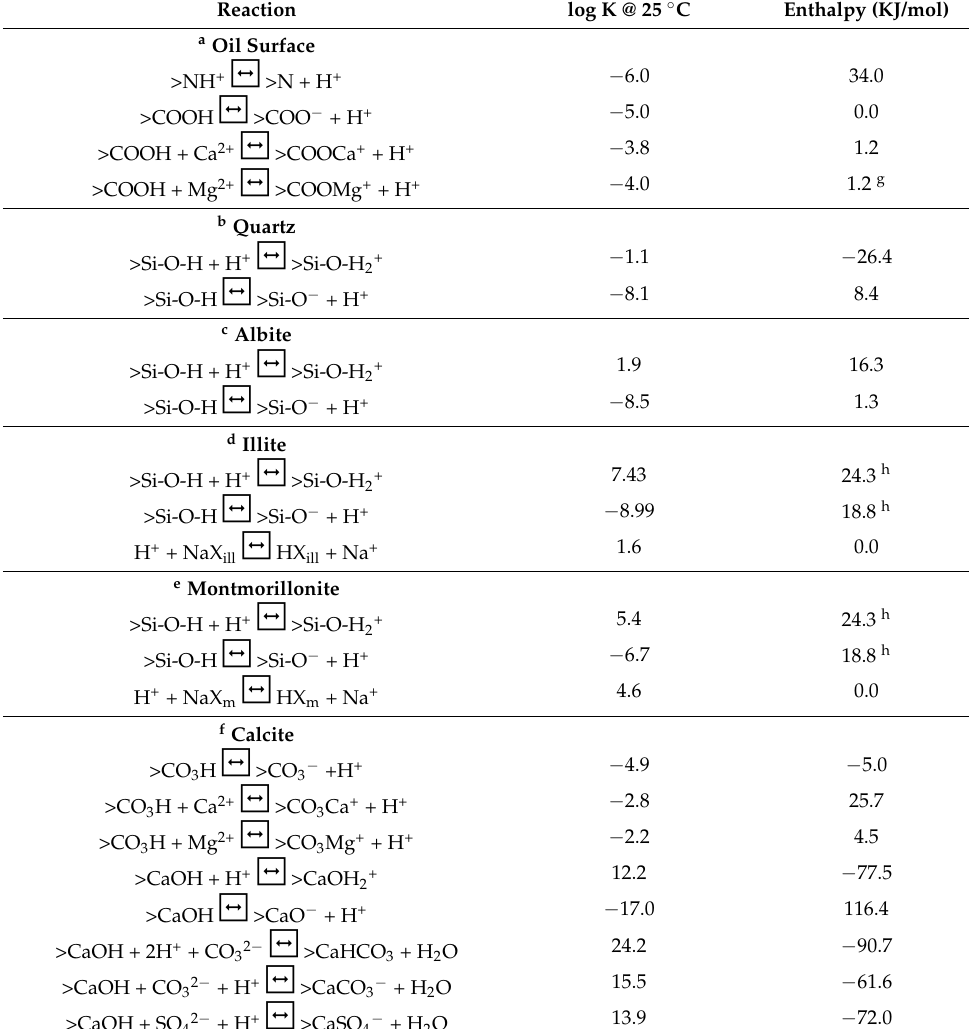
Table 4. SCM input parameters.